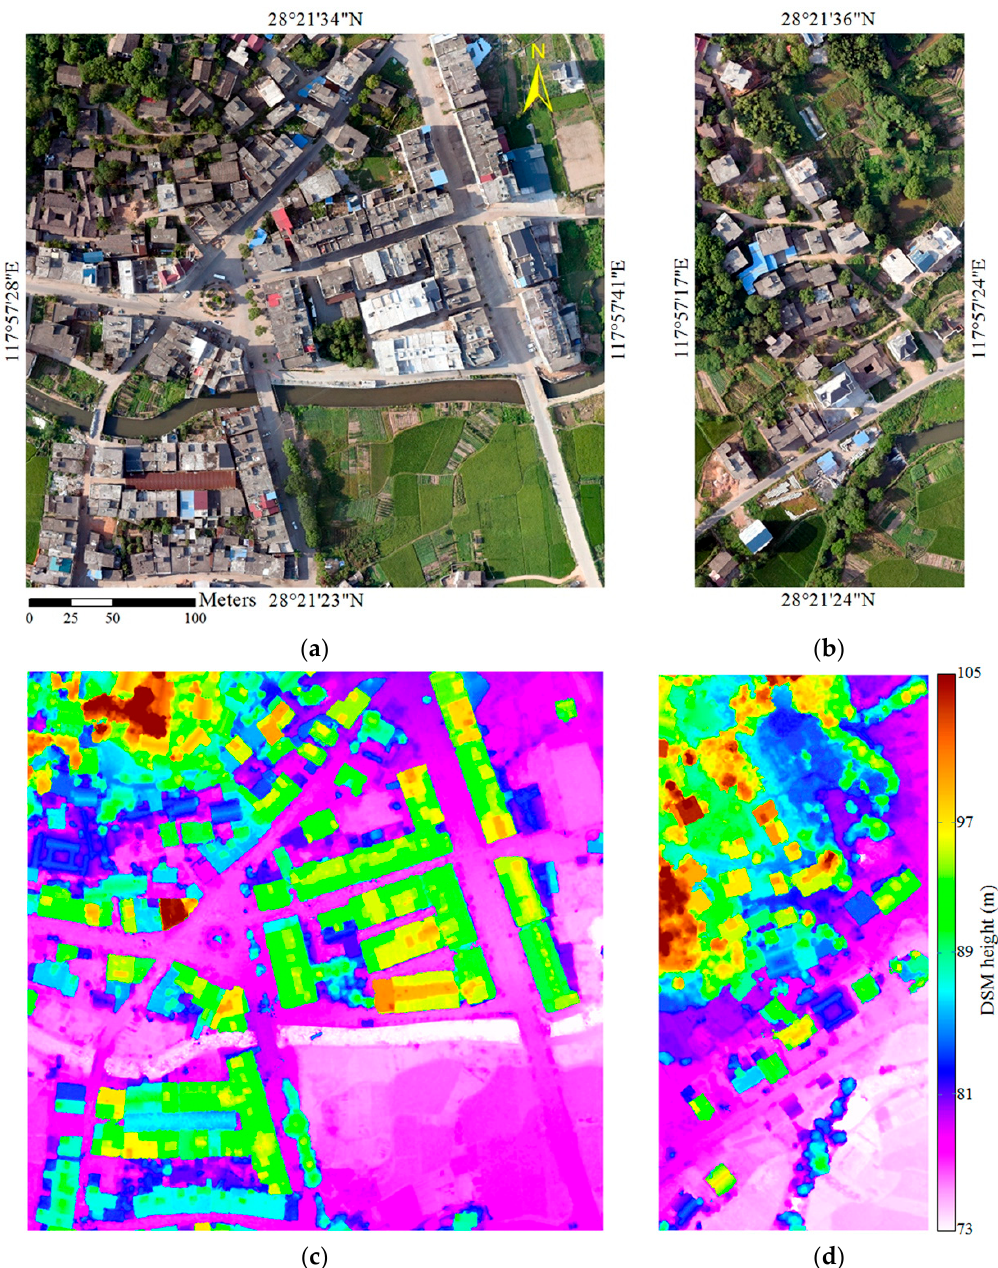
Figure 10. UAV orthoimages for the test regions ( a ) and ( b ) and the corresponding DSMs ( c ) and ( d ).